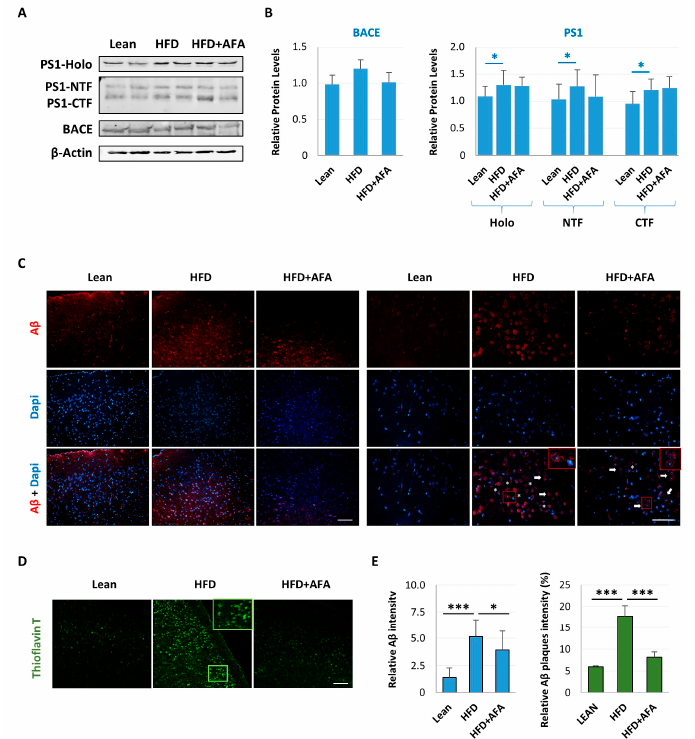
Figure 5. AFA treatment reduces A β deposition in HFD mouse brains. ( A ) Immunoblot of total lysate of Lean, HFD and HFD + AFA cortex incubated with anti-PS1, anti-BACE1 and anti- β -actin; ( B ) Quantification of immunoreactivity was performed using densitometric analysis; uniformity of gel loading was confirmed with β -actin utilized as standard. * p < 0.05, for Holo protein and PS1 fragments HFD vs. Lean; ( C ) Representative fluorescence images of the cortex of Lean, HFD and HFD + AFA mice. The A β fluorescence signal appears in the intracellular compartment of the cortex cells (arrows) in HFD + AFA mice and extracellular A β deposits are also present (asterisks) in HFD mice. Nuclei were stained with DAPI. Scale bars, 50 µ m and 20 µ m. ( D ) Thioflavin T staining of A β aggregates on cerebral cortex section of Lean, HFD and HFD + AFA mice. The outlined area in D is enlarged to the right to show the stained plaque. Thioflavin T-positive amyloid deposits are prominent in cortex areas of HFD mouse compared with those from Lean and HFD + AFA counterparts. Scale bar, 100 µ m. The outlined areas in C and D are enlarged. ( E ) The number and intensity of A β plaques detected by Thioflavin T were quantified using Image J software. All images were taken using a fluorescence microscope. Asterisks indicate significant differences between HFD vs. Lean and HFD + AFA vs. HFD (* p < 0.05, *** p <